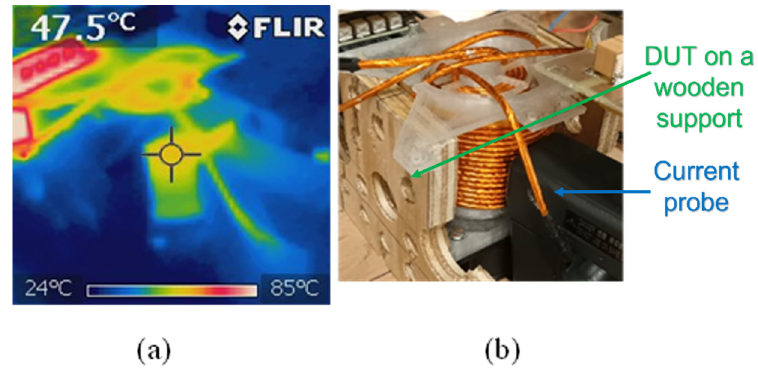
Figure 19. Thermal results: ( a ) Thermal camera picture; ( b ) Reference image.